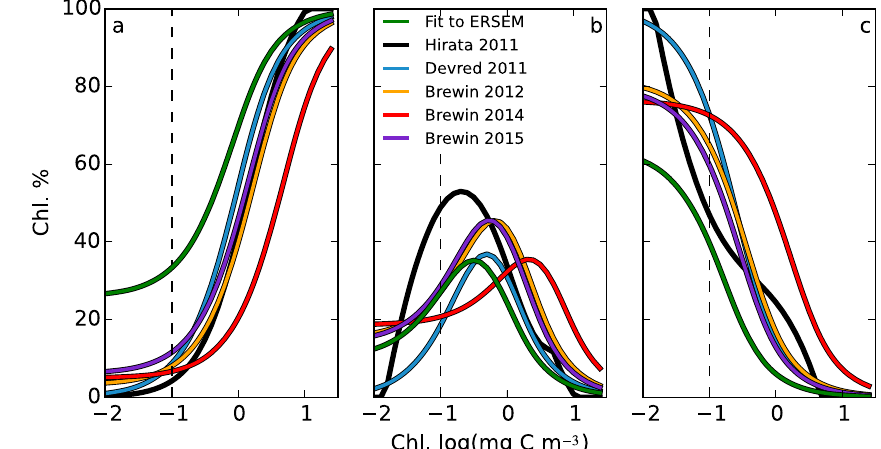
Figure 2. Phytoplankton community structure for all fits including the fit to ERSEM. The panes labelled (a) , (b) and (c) are diatoms and large phytoplankton, nanophytoplankton and picophytoplankton, respectively. The least-squared fit to the three-population absorption model to ERSEM is shown as a green line. The other coloured lines are the five fits from Hirata et al. (2011), Devred et al. (2011), and Brewin et al. (2012, 2014, 2015). The dashed vertical line indicates a typical detection limit of HPLC and SFF